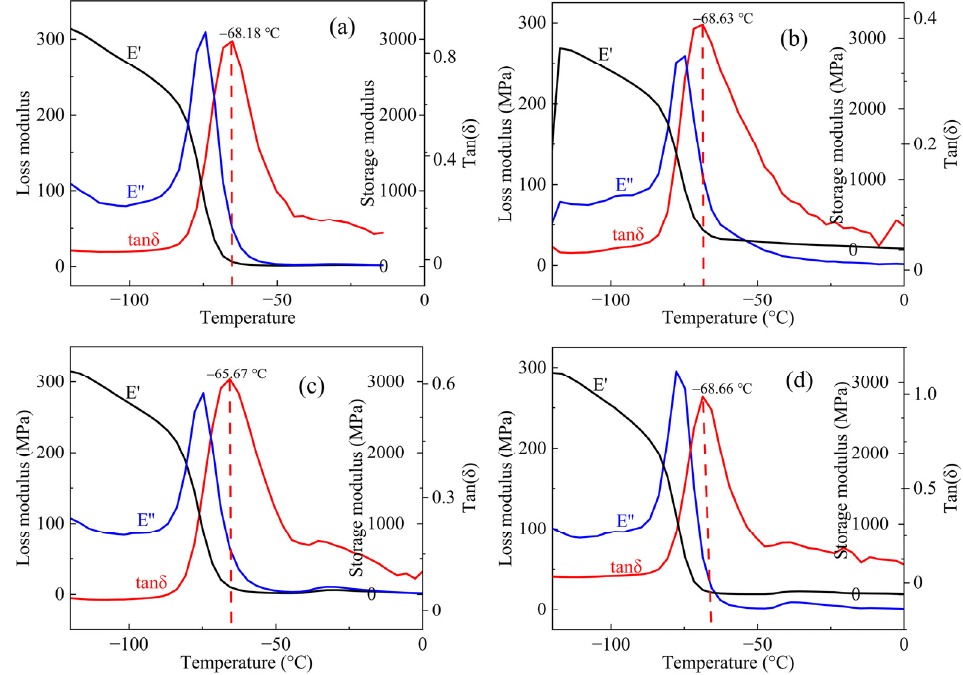
Figure 10. The DMA curves of four HTPE binder specimens. ( a ) S-1, ( b ) S-2, ( c ) S-3 and ( d )